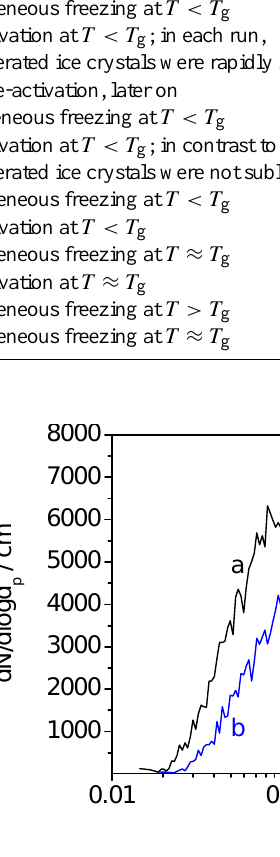
Fig. 3. Combined SMPS and APS number size distributions of aqueous raffinose particles after injection at 246K (a) and subse- quent cooling to 230K (b)